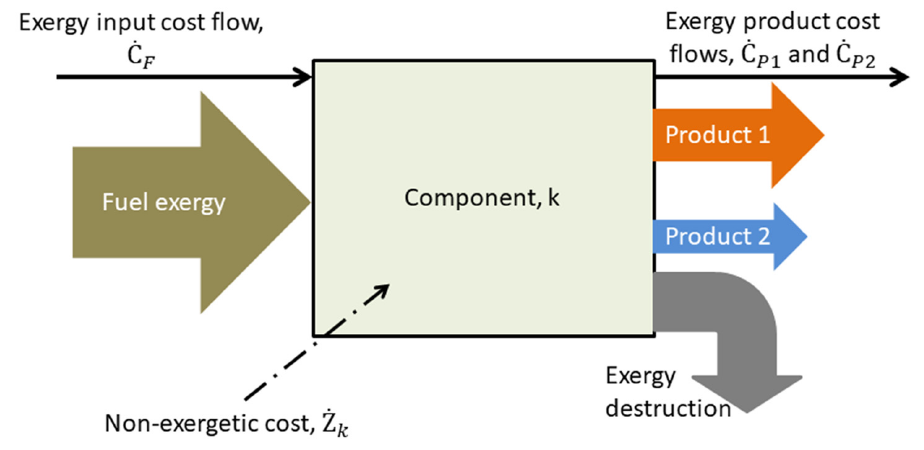
Figure 1. The principle of exergo-economic balance.